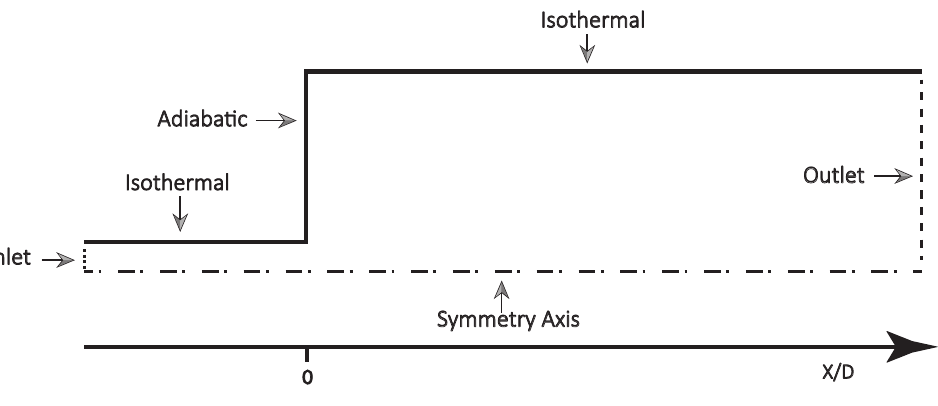
Figure 6. Boundary conditions corresponding to the experimental